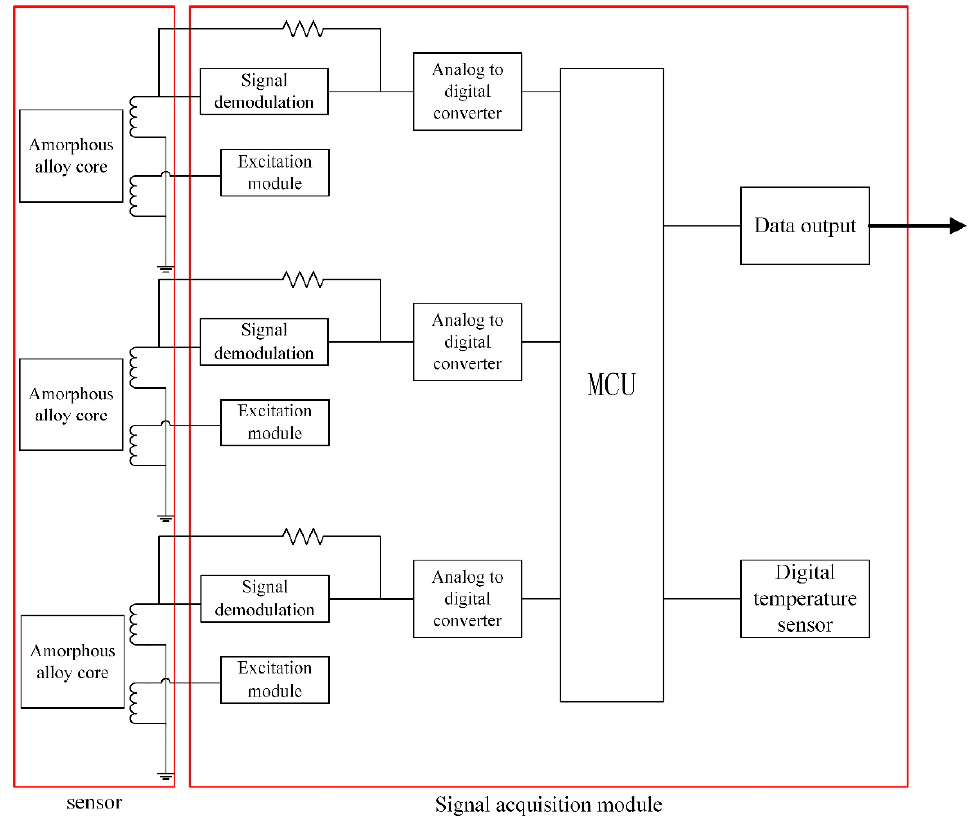
Figure 6. Simplified block diagram of the sensor processing circuitry.